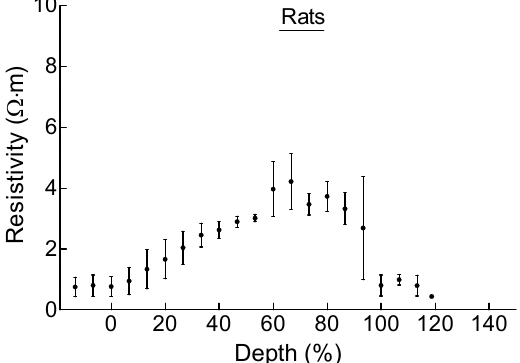
Fig. 10: Mean resistivity ( ± SD) vs. percentage depth profile of five chick embryo retina samples of which three are extracted from E18 and two from E12. E18 have a higher peak mean resistivity than the E12 chick trials.